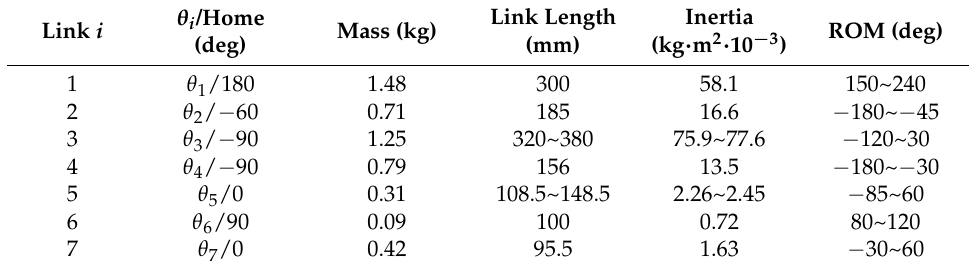
Table 1. Kinematics and dynamics parameters of the upper limb exoskeleton Link